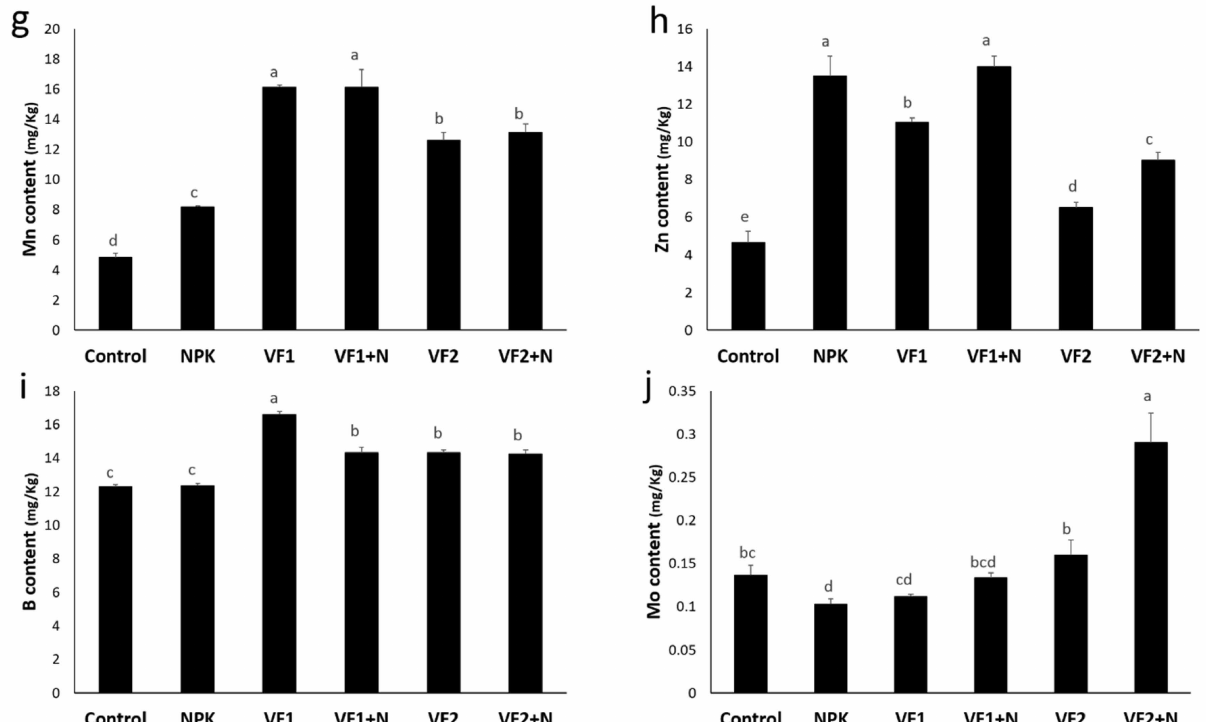
Figure 8. Fruit mineral content (( a ) Nitrogen, ( b ) Phosphorus, ( c ) Potassium, ( d ) Magnesium, ( e ) Calcium, ( f ) Iron, ( g ) Manganese, ( h ) Zinc, ( i ) Boron and ( j ) Molybdenum) of tomato treated with vitreous and chemical fertilizers in open field. NPK: conventional fertilizer; VF1: formula 1 of the vitreous fertilizer, VF2: formula 2 of the vitreous fertilizer; N: Nitrogen. Bars with different letters are significantly different according to Tukey’s HSD test, after performing one-way ANOVA ( p <